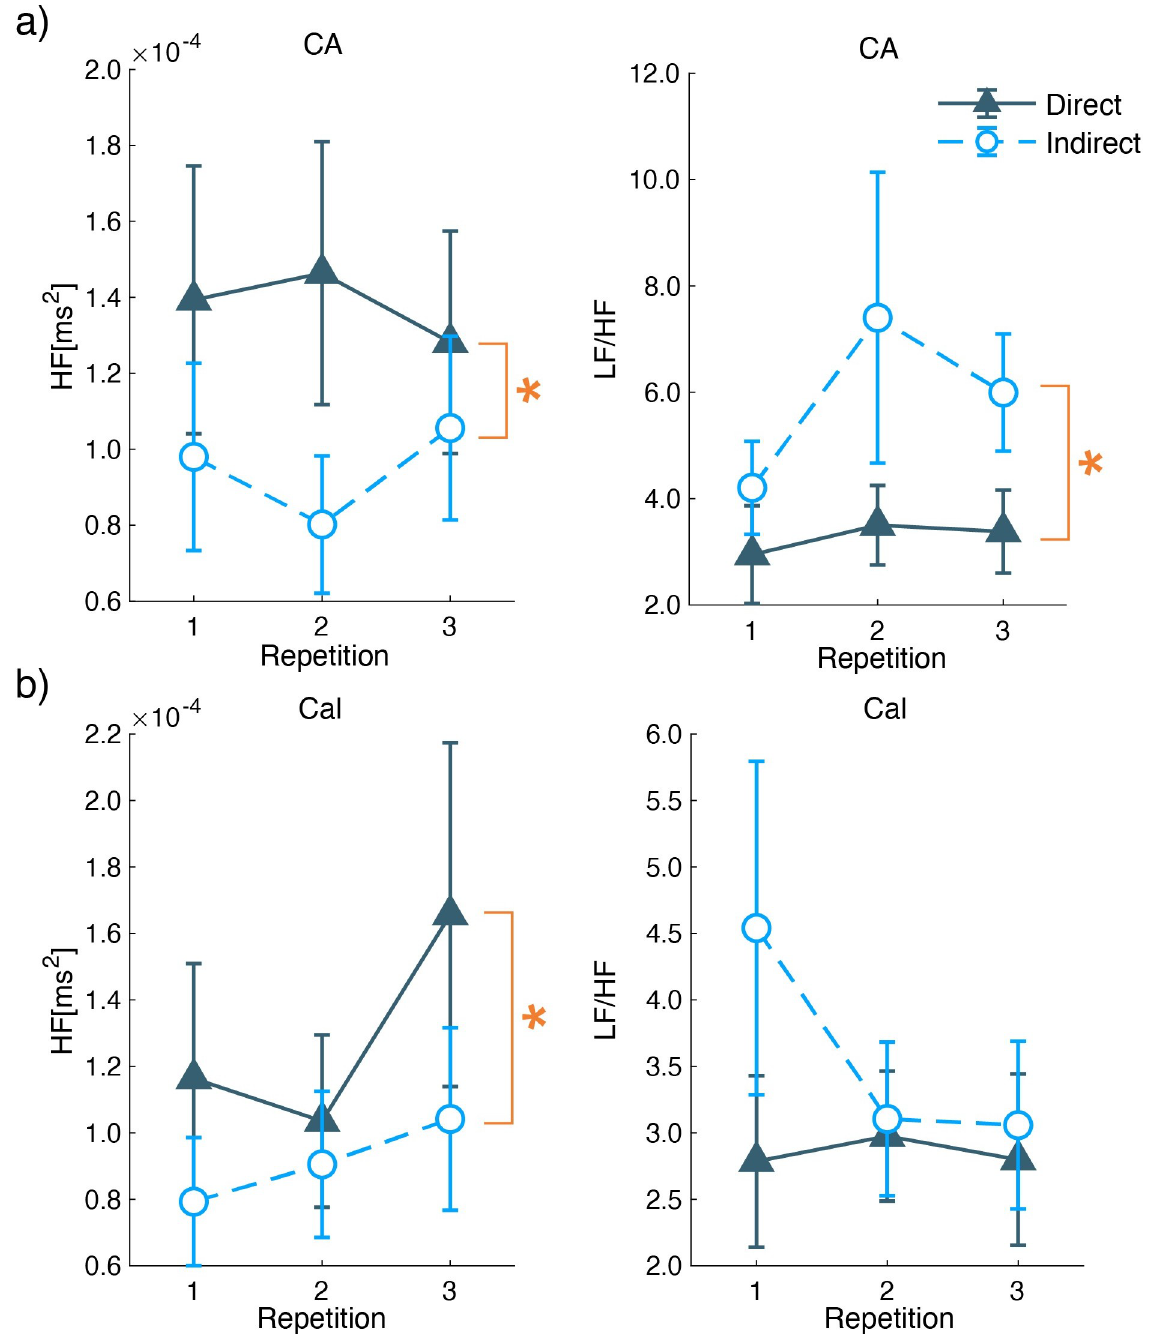
Fig 13. ECG parameters of HF and LF/HF during a) CA and b) Cal. The right row shows the mean and standard error of HF, and the left row shows that of LF/HF. The X-axis shows the repetition. The U-shaped lines with larger asterisks show significant main effects of the airflow condition obtained by two-way ANOVA. ( � : P <